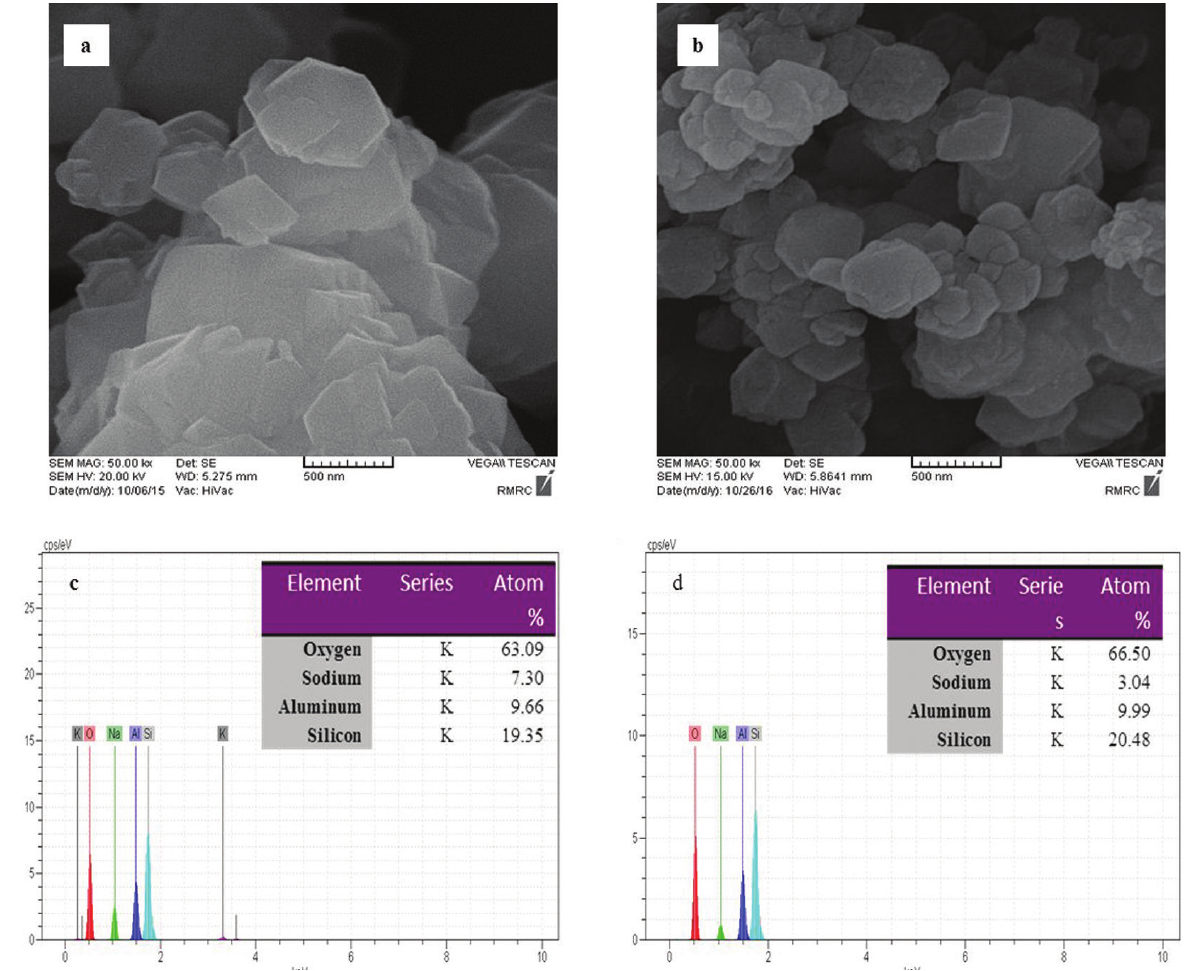
Figure 5: The SEM micrographs of (a) microporous zeolite NaY, (b) hierarchical MY and the EDX plots of (c) microporous NaY, (d) hierarchical MY zeolites; insets show the elemental percentages.